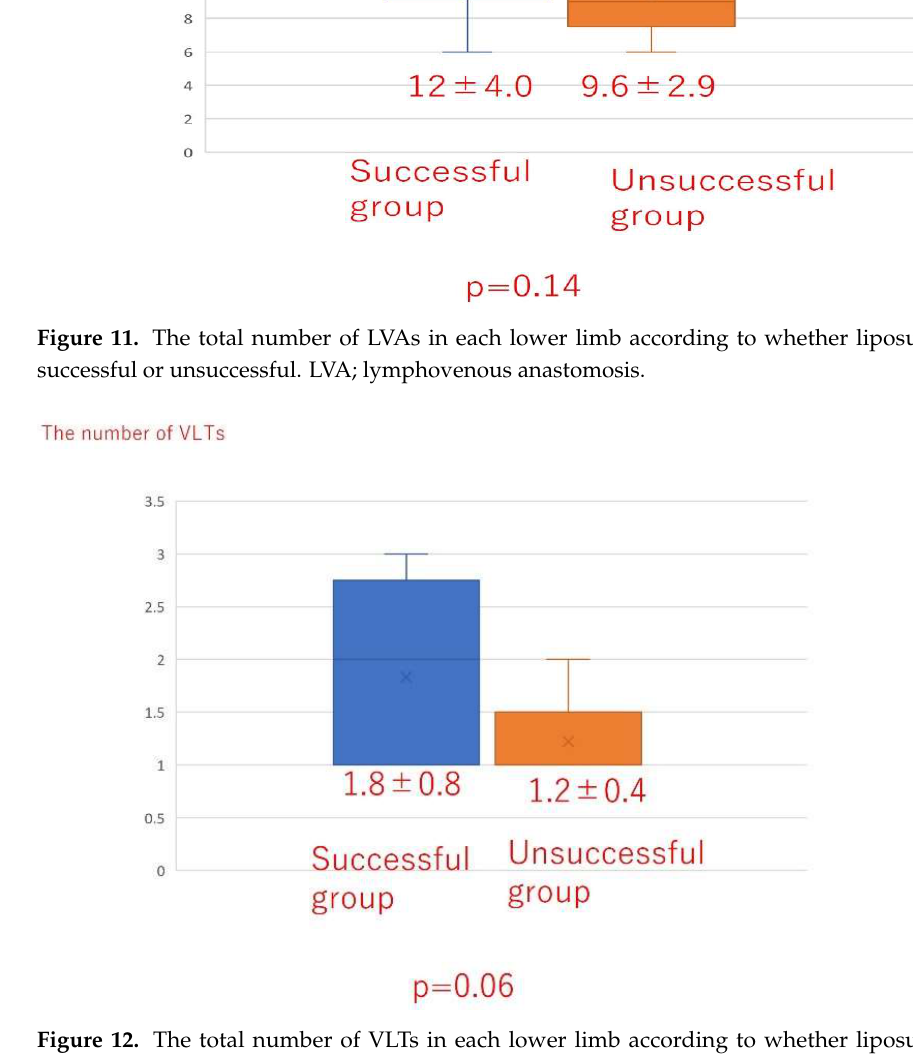
Figure 12. The total number of VLTs in each lower limb according to whether liposuction was successful or unsuccessful. VLT; vascularized lymphatic transplant.